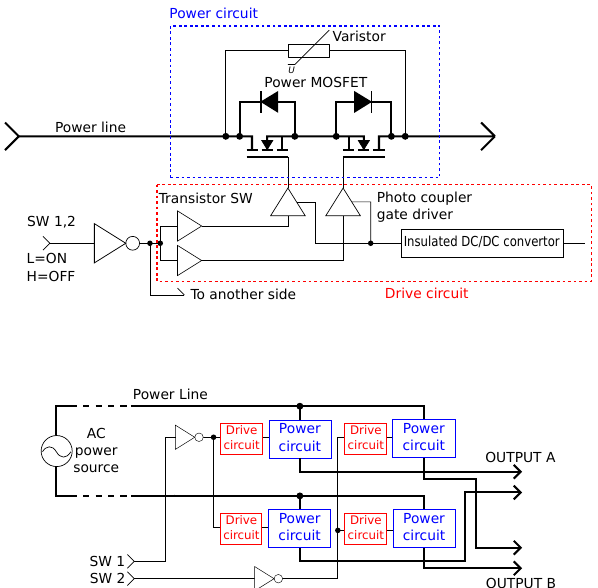
Figure 5. Power router switch layout and how a single input is transmitted to either of the two available